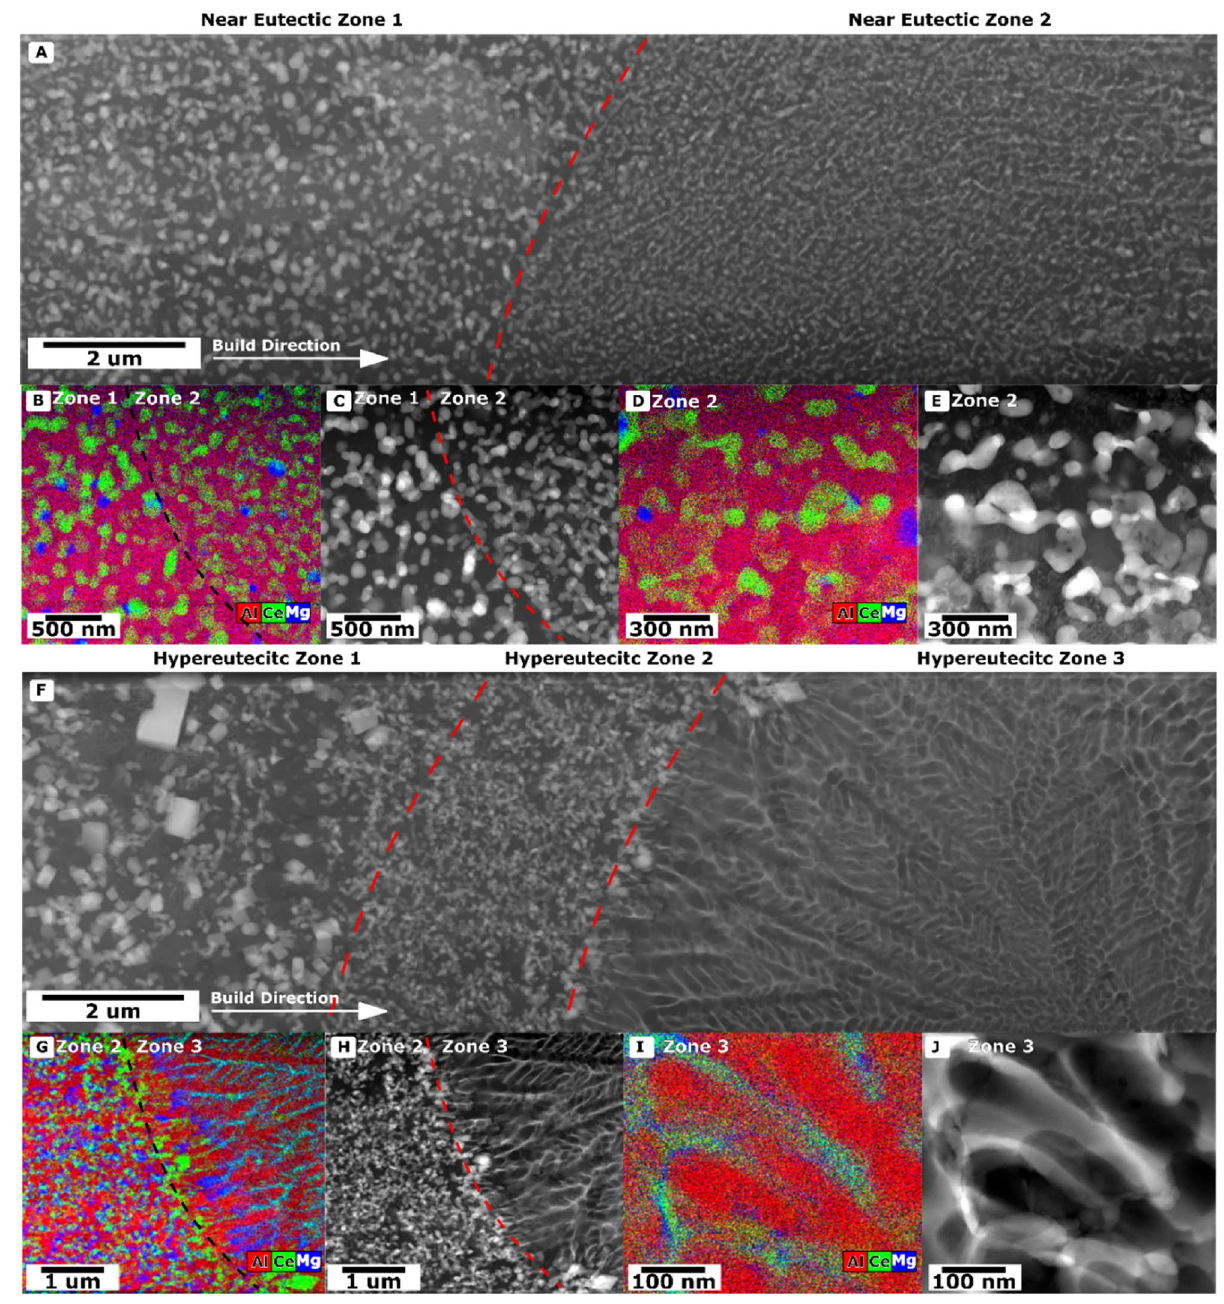
Figure 5. ( A ) HAADF View of Near Eutectic TEM Foil across the weld pool boundary. A symbolic arrow is shown in Fig. 4A. ( B ) STEM Combined Map of Elements for Region C for the Near Eutectic Alloy. ( C ) Bright Field of Dendritic region across Zone 1 and Zone 2 for the Near Eutectic Alloy. ( D ) STEM Combined Map of Elements for E for the Near Eutectic Alloy. ( E ) HAADF View across the edge of the weld pool into the dendrite region for the Near Eutectic Alloy. ( F ) HAADF View of TEM Foil for Hypereutectic Alloy across the weld pool boundary. A symbolic arrow is shown in figure. ( G ) STEM Combined Map of Elements for Region H for the Hypereutectic Alloy. ( H ) Bright Field of Dendritic region across Zone 2 and Zone 3 for the Hypereutectic Alloy ( I ) STEM Combined Map of Elements for J for the Hypereutectic Alloy. ( J ) HAADF View across the edge of the weld pool into the dendrite region for the Hypereutectic